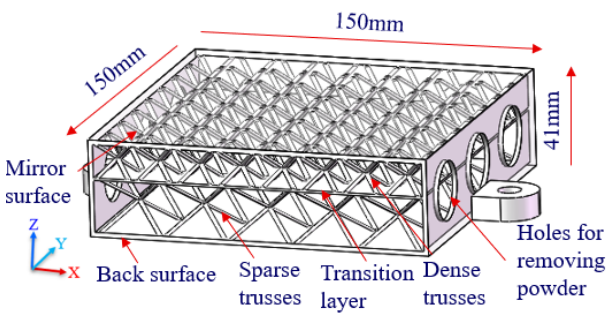
Figure 3. Cut view of the mirror model with double-layer truss structure.